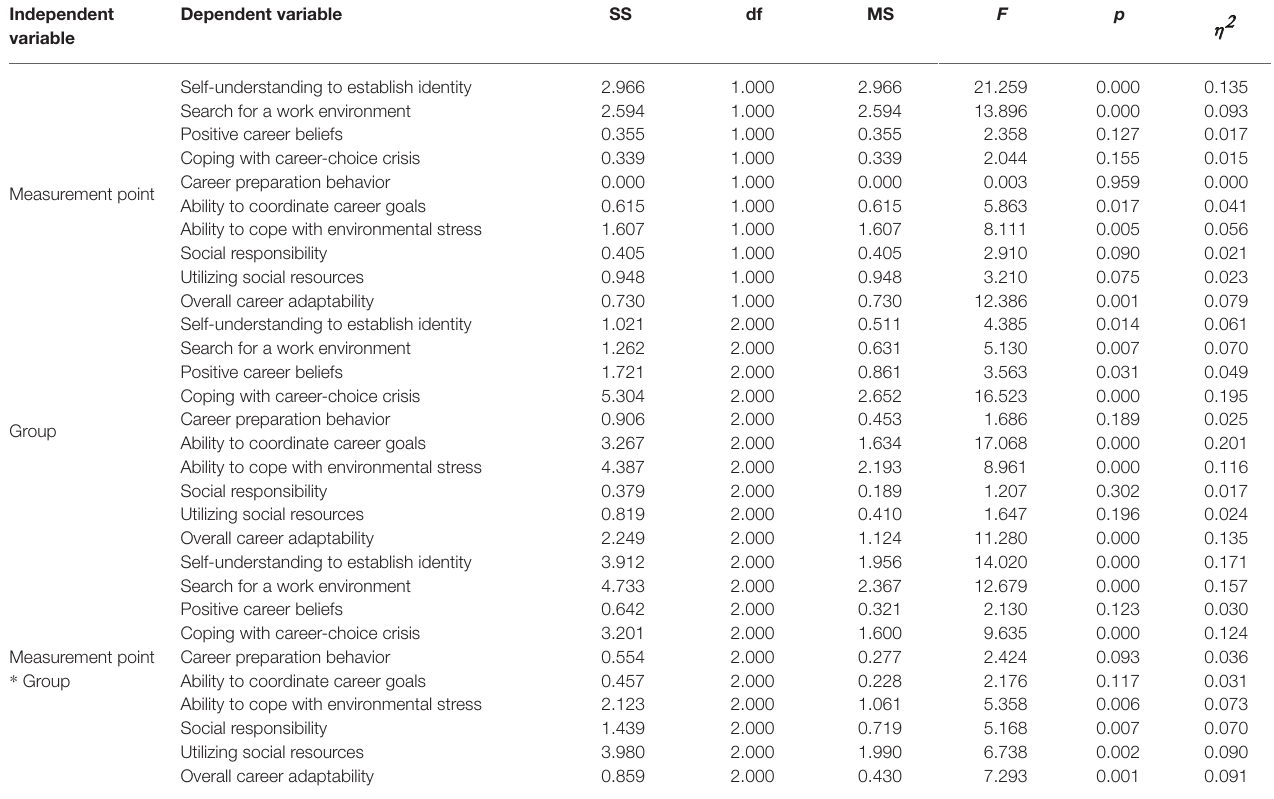
TABLE 5 | Pre-post-comparison of the program (RM ANOVA). Independent Dependent variable variable